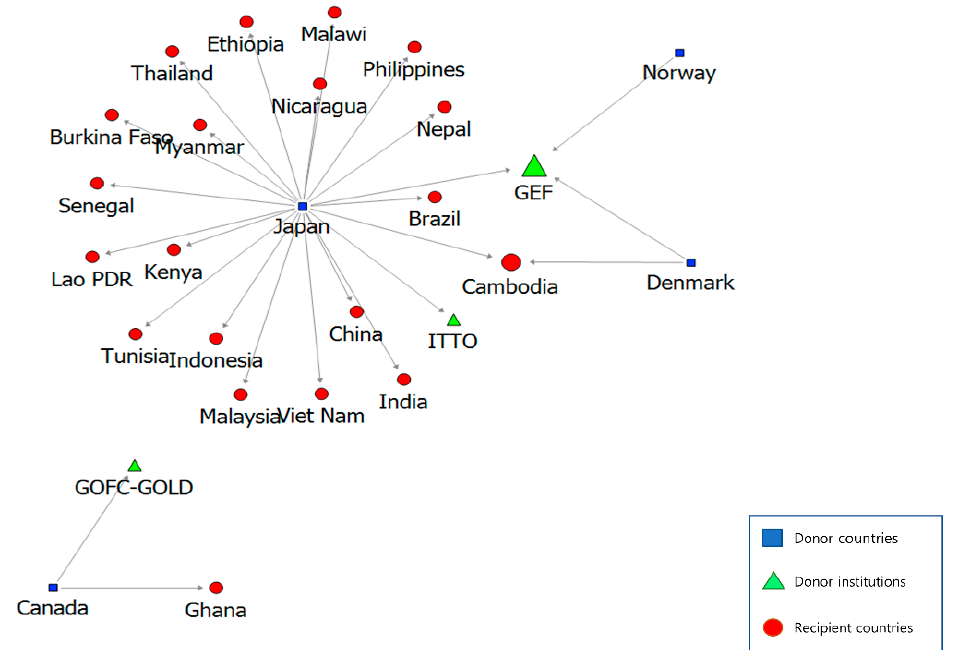
Figure 2. In-degree centrality in global REDD+ financial network in 2006.